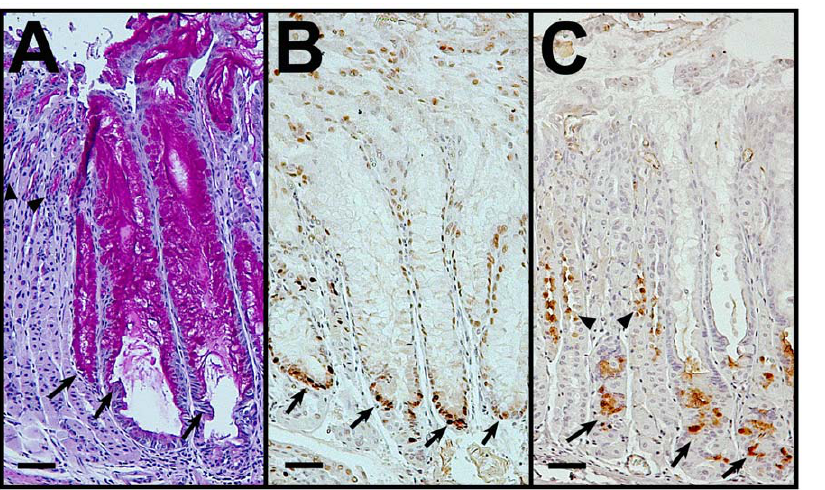
Figure 5. Kras G12D mutation led to foveolar hyperplasia in the gastric fundus. A. PAS (pink) showed extensive mucin production deep into affected glands while surrounding normal glands only had staining at the tops of glands. B. Immunolabeling for phosphohistone H3 as an M phase marker. The proliferative zone in affected glands was shifted toward the base of the glands. C. Immunolabeling for TFF2 (brown) showed positive cells near base of affected fundic glands while normal glands had expression in the normal mucous neck region. Arrows, staining in affected glands; arrowheads, staining in normal glands. Size bars, 50 m m.